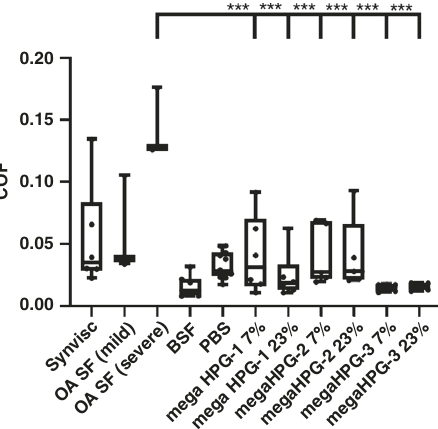
Fig. 4 Determination of COF of mega HPGs. COF values for cartilage on cartilage with each lubricant after equilibrating in creep, as shown with box- and-whiskers plot. Whiskers represent (min to max), bounds of box represent lower (25 th percentile) and upper quartile (75 th percentile), and center line represents median. Error bars represent standard deviation, N = 3 or greater replicates; one-way ANOVA used to compare groups, statistical differences indicated by asterisk, where * p < 0.05, ** p < 0.01, **** p < 0.0001. For full list of statistical results see Supplementary